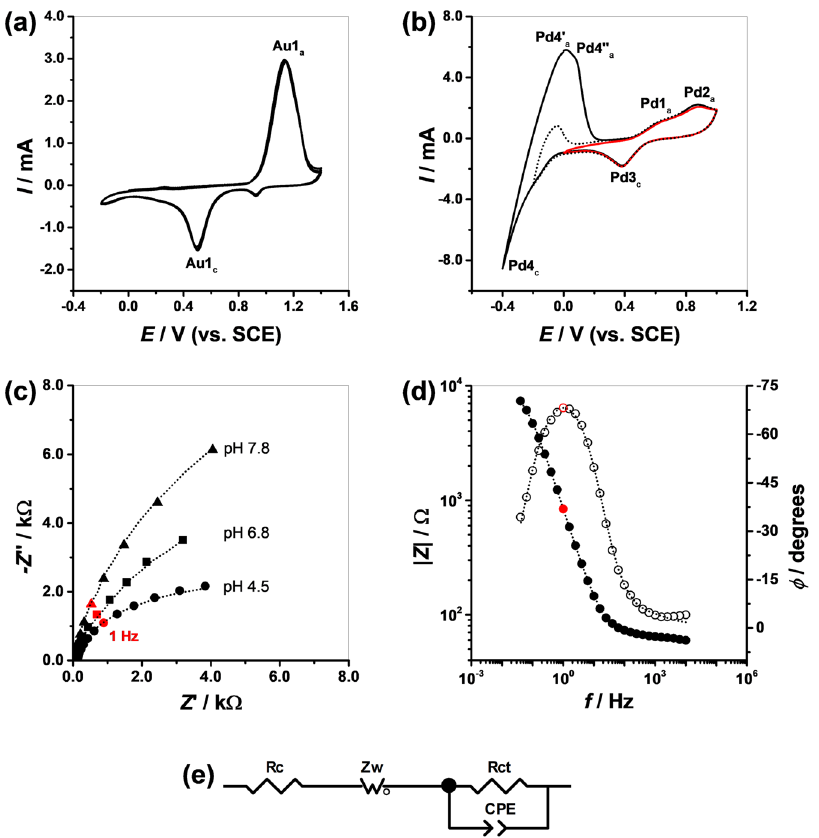
Figure 5. ( a , b ) Cyclic voltammograms in 0.1 M H 2 SO 4 at v = 100 mV s − 1 of: ( a ) Au/PMMA/PET and ( b ) PdO/ Pd/Au/PMMA/PET. ( c , d ) EIS spectra of Pd-PdO/Au/PMMA/PET: ( c ) Nyquist diagram representing the imaginary component – Z ” vs. the real component Z ’ of the total impedance Z recorded in electrolytes with different pH values. ( d ) Bode diagram representing | Z | and phase angle ϕ vs. frequency f recorded in pH 4.5. ( e ) Schematic representation of the circuit used to fit the experimental EIS data points. The dotted curves represent the fitting results of the experimental data points with the equivalent